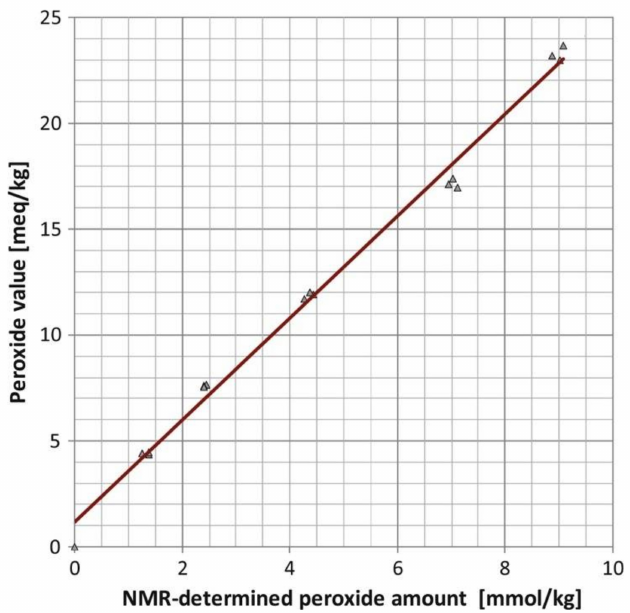
Figure 31. Peroxide value in mequiv/kg versus the NMR-determined peroxide amount in mmol/kg. Reprinted with permission from [130]. Copyright 2012,